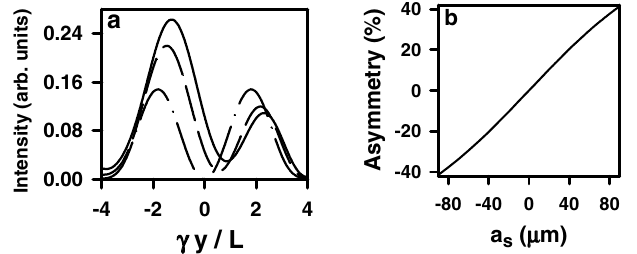
FIG. 7. (a) DR spatial distribution calculated for different electron beam trajectory offsets with respect to the target slit (cid:5) 0 , dashed line— a (cid:5) 65 (cid:8) m , center: dash-dotted line— a s s (cid:5) 90 (cid:8) m . (b) DR spatial distribution asym- and solid line— a s metry as a function of the electron offset. Calculation parame- (cid:5) 9 mm , a (cid:5) 0 : 185 mm , ters: (cid:1) (cid:5) 2500 , (cid:2) (cid:5) 500 nm , a out in (cid:5) 7 mm , b (cid:5) 5 mm , b (cid:5) 0 , (cid:6) (cid:5) 45 (cid:14) , j R j 2 (cid:5) 0 : 61 , b s x out in 0 j 2 (cid:5) 0 : 37 . and j R y